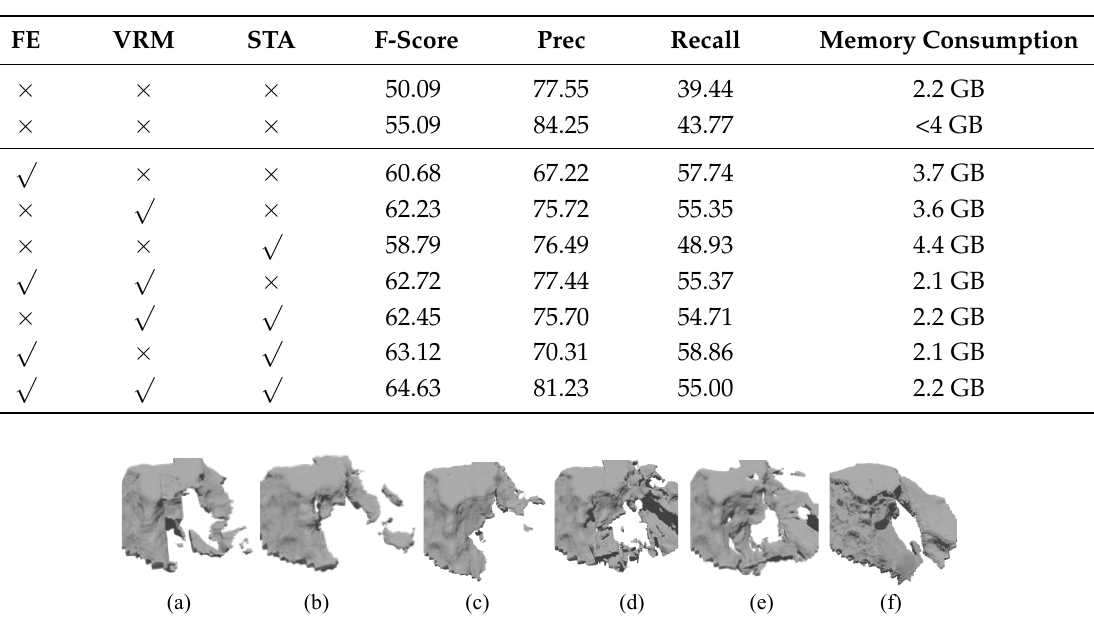
Table 5. Ablation study on the proposed three modules, i.e., feature enhancement (FE), view reweighted mechanism (VRM), and spatial–temporal aggregation (STA).